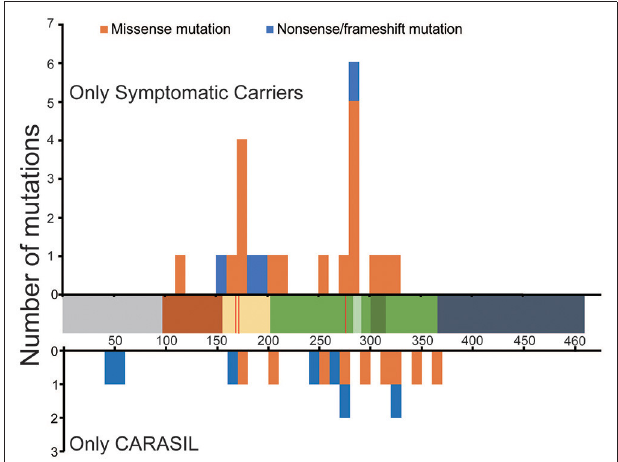
FIGURE 1 | Location and frequency of mutations found in HTRA1 genes. Distribution of HTRA1 mutations. The number of mutations per 10 amino acids is shown. The upper bar graph indicates the mutations observed only in symptomatic carriers. The lower bar graph indicates the mutations observed in CARASIL patients alone. The horizontal axis shows the number of amino acids (AAs) in HTRA1 protein. The residues, which are important for trimerization, are indicated by the red line. Each colored box represents a functional domain, which are colored as follows: gray [N-terminus (1–98 AA)], brown [Kazal-like domain (99–157AA)], yellow [linker region(158–203 AA)], green [protease domain (204–364 AA)], light green [LD loop (283–291 AA), dark green [L3 loop (301–314 AA)], and navy blue [PDZ region (365–467 AA)]. The blue bar represents nonsense or frameshift mutations and the orange bar represents missense